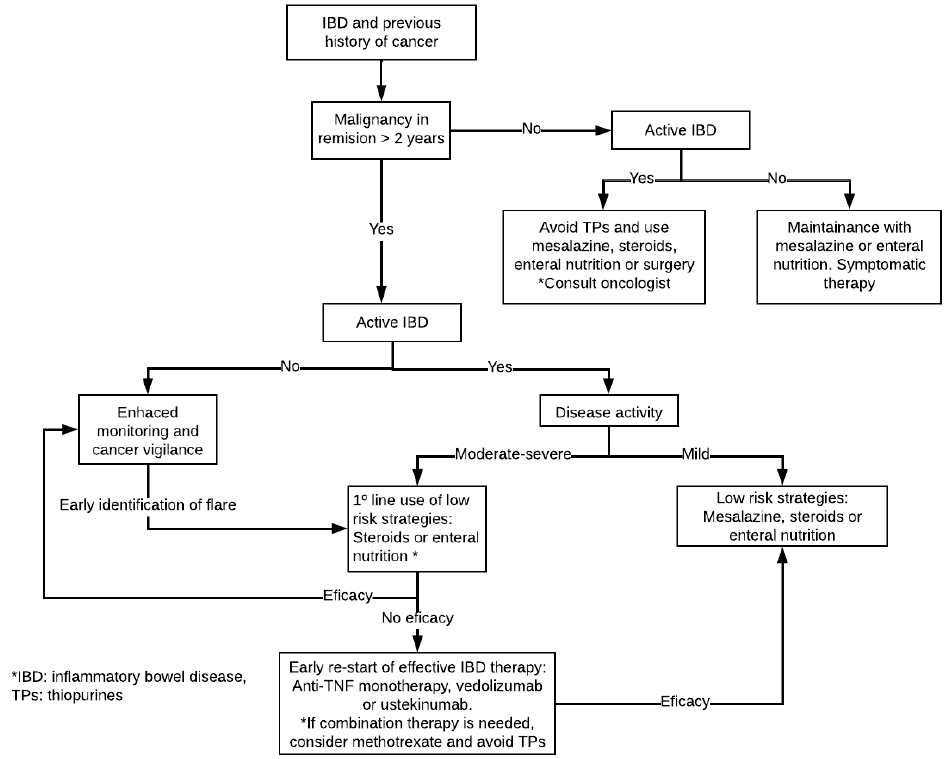
Figure 2. Suggested algorithm for the management of patients with IBD and prior history of cancer.